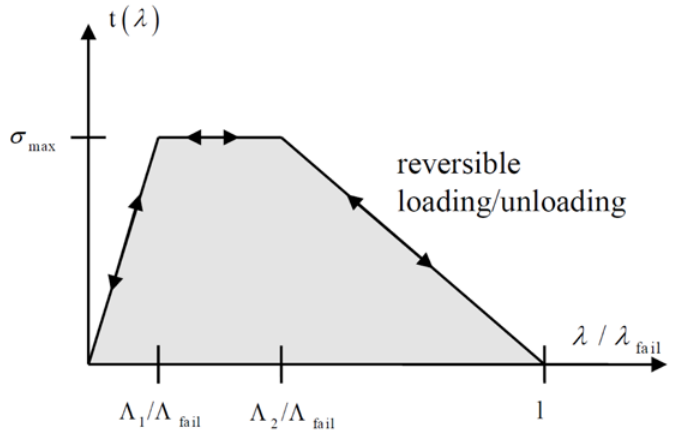
Figure 4. A trilinear constitutive relation of 185 material [22].